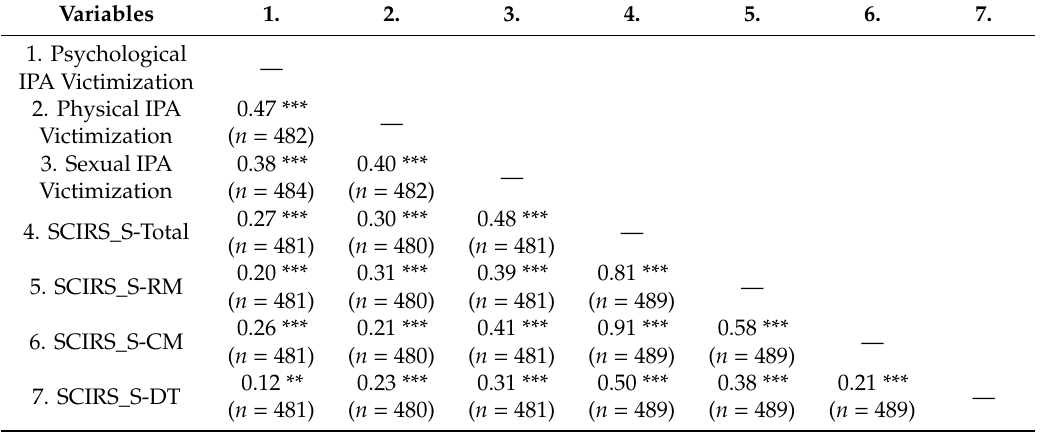
Table 2. Correlations between IPA Victimization and Sexting